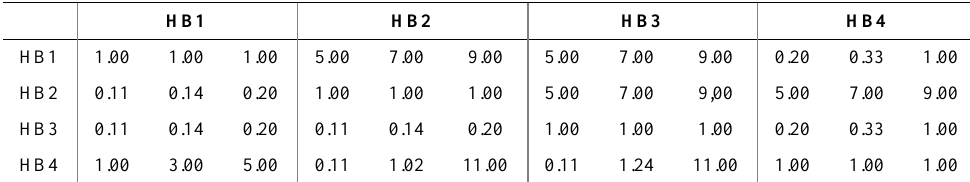
Table 6. Representative Matrix of Obstacles to Process/Business Criteria HB1